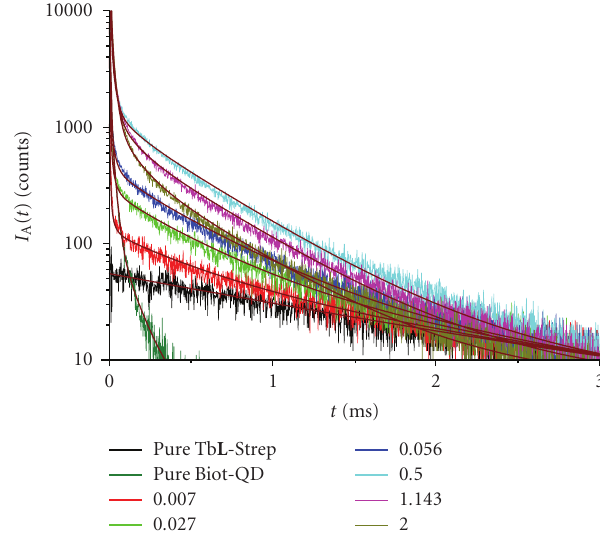
Figure 1: Luminescence decay curves for pure Tb L -Strep (c = 1 · 10 − 9 M) and mixtures of Tb L -Strep + Biot-QD with ratios be- tween 0.007 and 2.0 Biot-QD per Tb L -Strep measured in channel A ((665 ± 5)nm). A background decay curve of pure Biot-QD (c = 1 · 10 − 10 M) arising from a strong detector saturation of short- lived directly excited QD fluorescence is also displayed. Fits accord- ing to (1) displayed as thick solid lines.